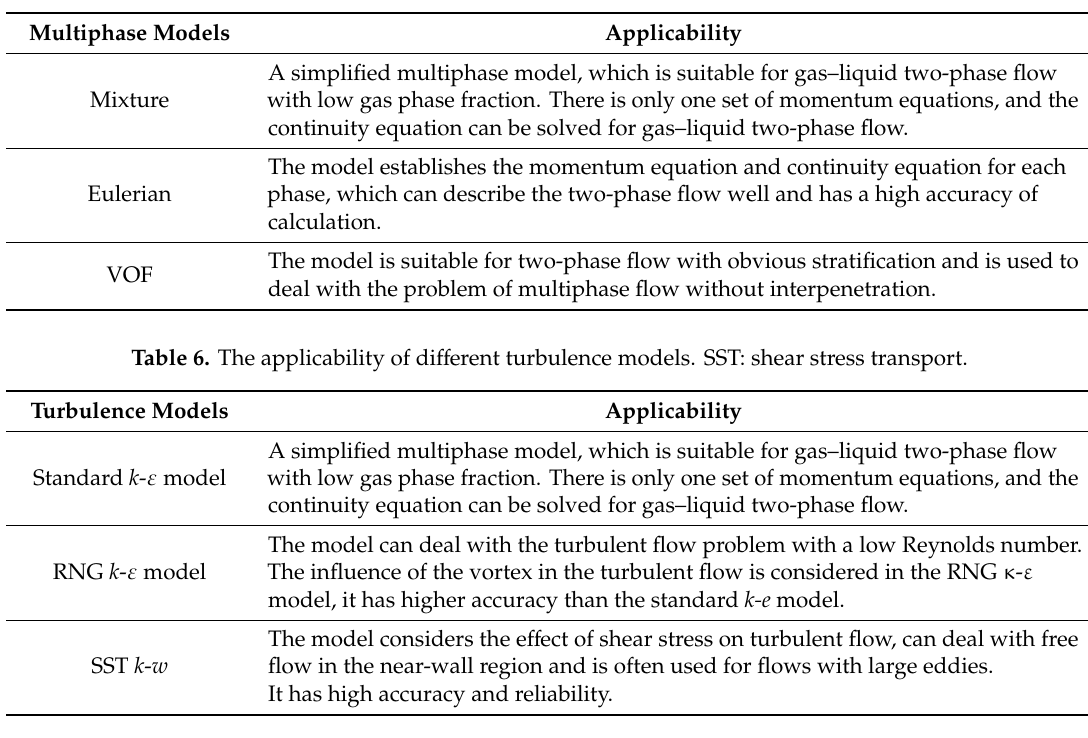
Table 5. The applicability of di ff erent multiphase models.